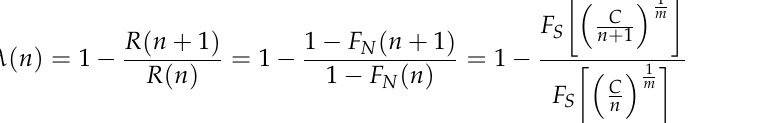
Table 1. The test data of Ti-6246 alloy.